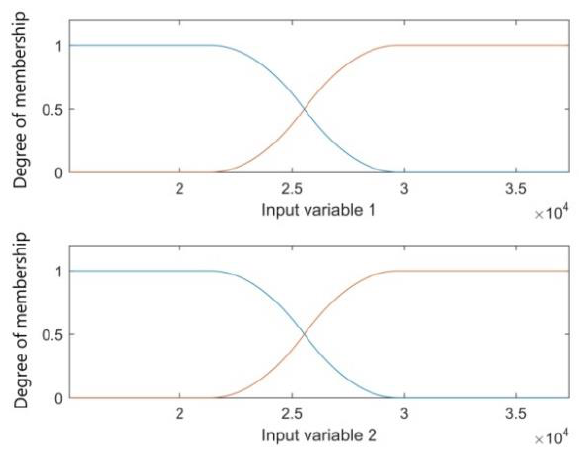
Figure 7. Estimated membership functions for the prediction model.